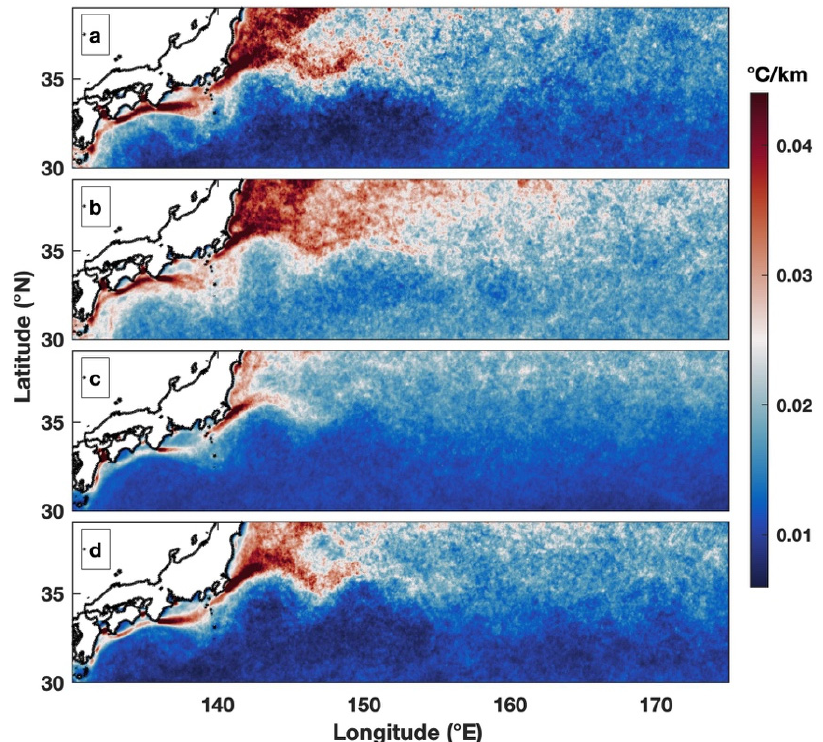
Figure 4. Seasonal variability of the sea surface temperature (SST) gradient (°C/km). The seasons are ( a ) winter (January– March), ( b ) spring (April–June), ( c ) summer (July–September), and ( d ) fall (October–December).